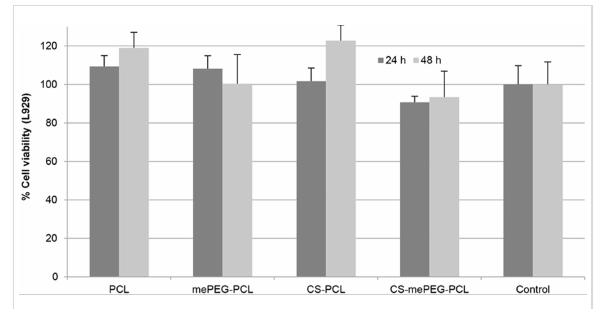
Figure 6: Cell viability of blank nanoparticles for 24 and 48 h ( n = 3, ± SD).